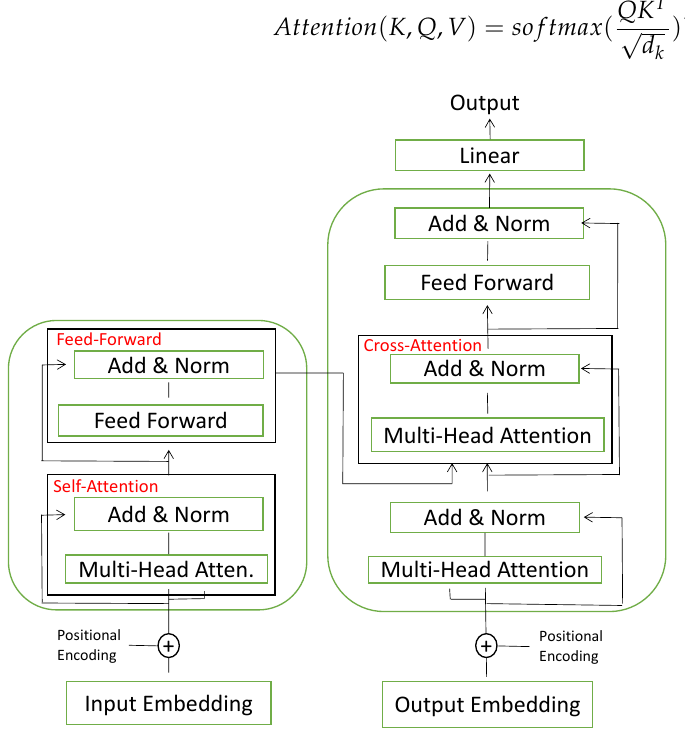
Figure 4. The overview sketch of